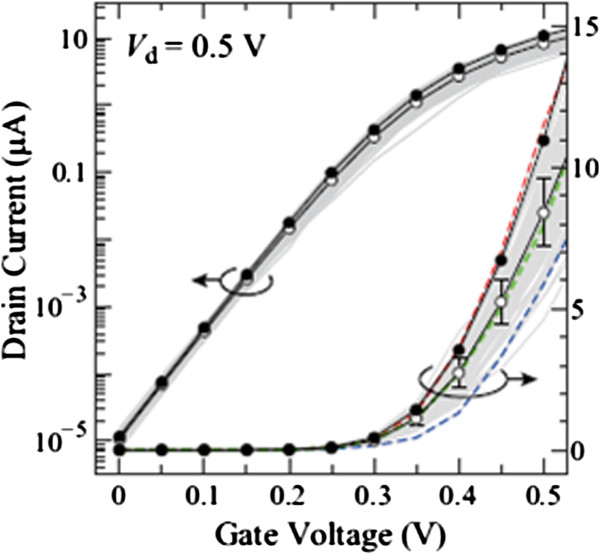
Id-Vgcharacteristics of GAA Si NW transistors atVd = 0.5 V. Gray lines show the Id-Vg of 100 samples with different discrete As distributions. Open circles represent their average value 〈Id〉. The continuously doping case with Nd = 3 × 1020 cm−3 in the S/D extensions is shown by solid circles for comparison.